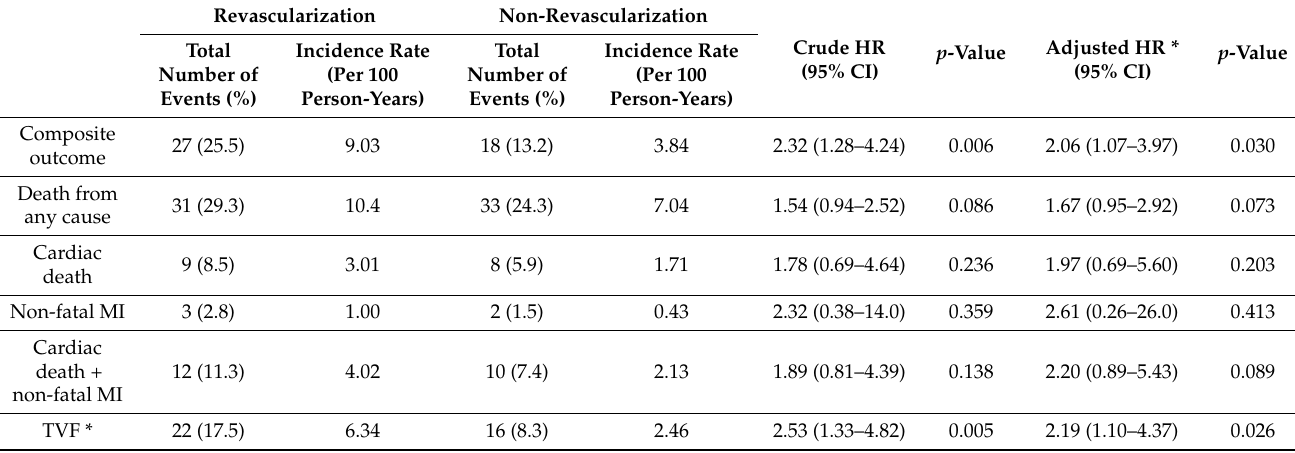
Table 3. Incidence of clinical outcomes and adjusted hazard ratio of FFR-guided treatment strategy in a CKD population.